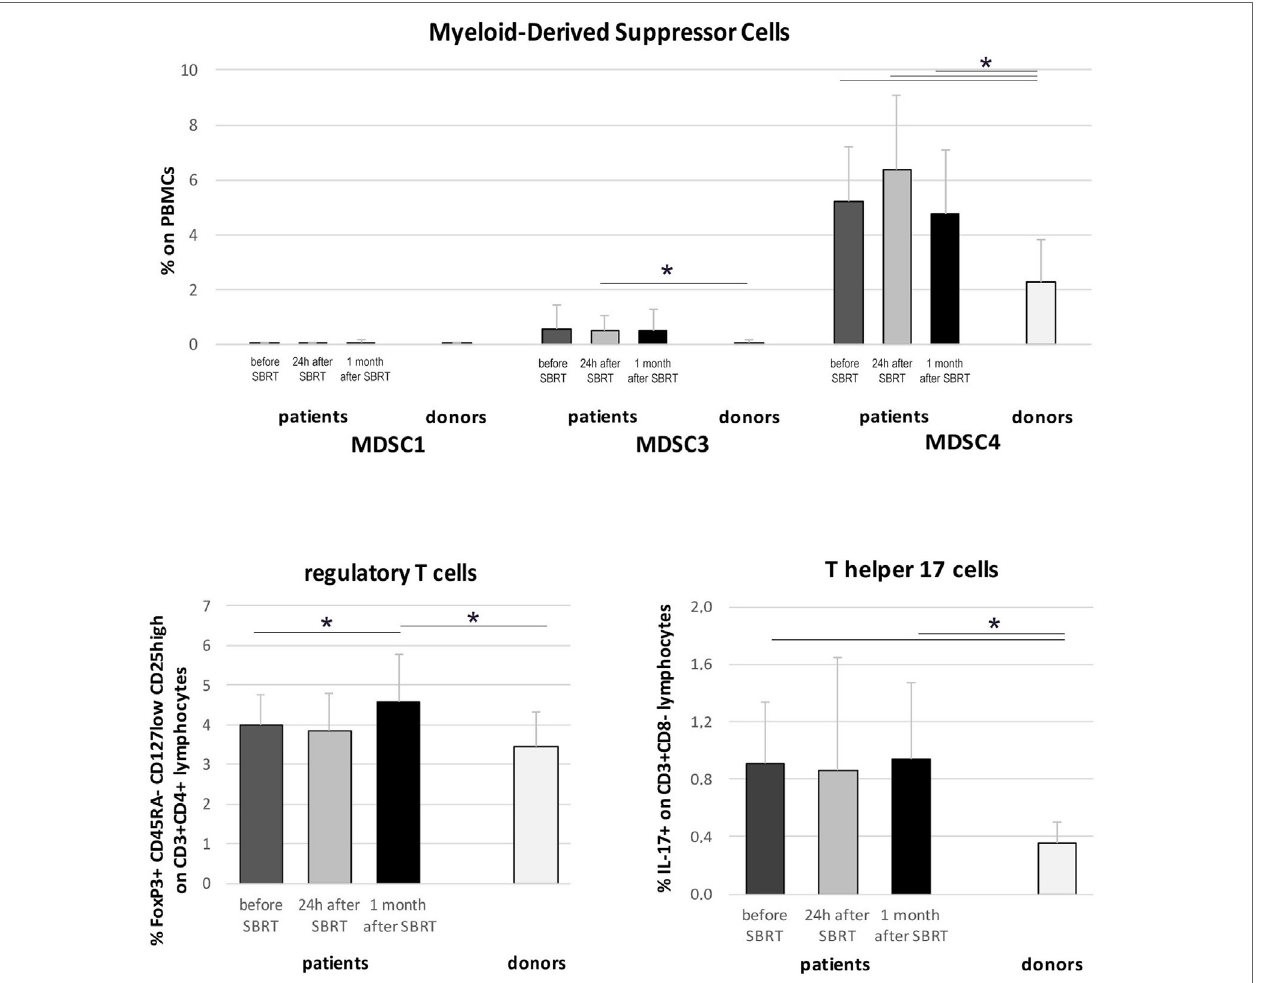
FigUre 3 | Immunophenotyping in oligometastatic breast cancer (BC) patients before and after SBRT. Flow cytometry characterization of immune populations in the peripheral blood of oligometastatic BC patients ( n = 12) before (dark gray), 24 h after the first SBRT fraction (light gray), and 1 month after SBRT (black) and in the peripheral blood of healthy women (donors; n = 9). Cell subsets were identified as follows: B cells as CD20 + lymphocytes, natural killer (NK) cells as CD3 − CD16 + CD56 dim lymphocytes, T cells as CD3 + lymphocytes, activated CD4 + cells as CD3 + CD4 + CD69 + lymphocytes, MDSC1 as CD14 + CD124 + cells, MDSC3 as CD33